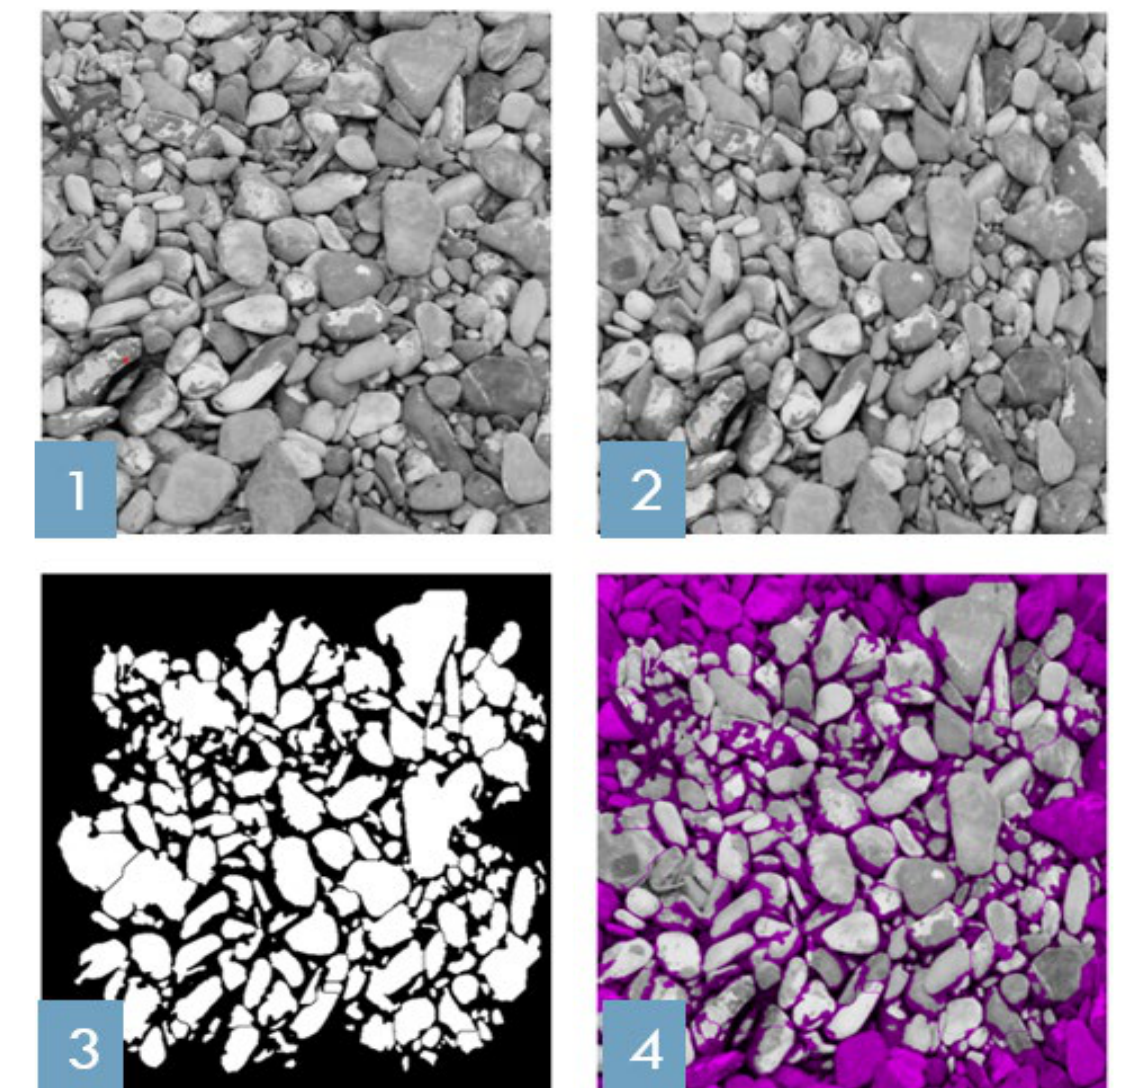
Figure 4. Graphical illustration of the key steps performed in the Digital Gravelometer software for the identification and measurement of different grain sizes: ( 1 ) Greyscaling; ( 2 ) projection transfor- mation for camera adjustment; ( 3 ) grain selection; ( 4 ) greyscale image mask overlay on the selected grains in the previous step.